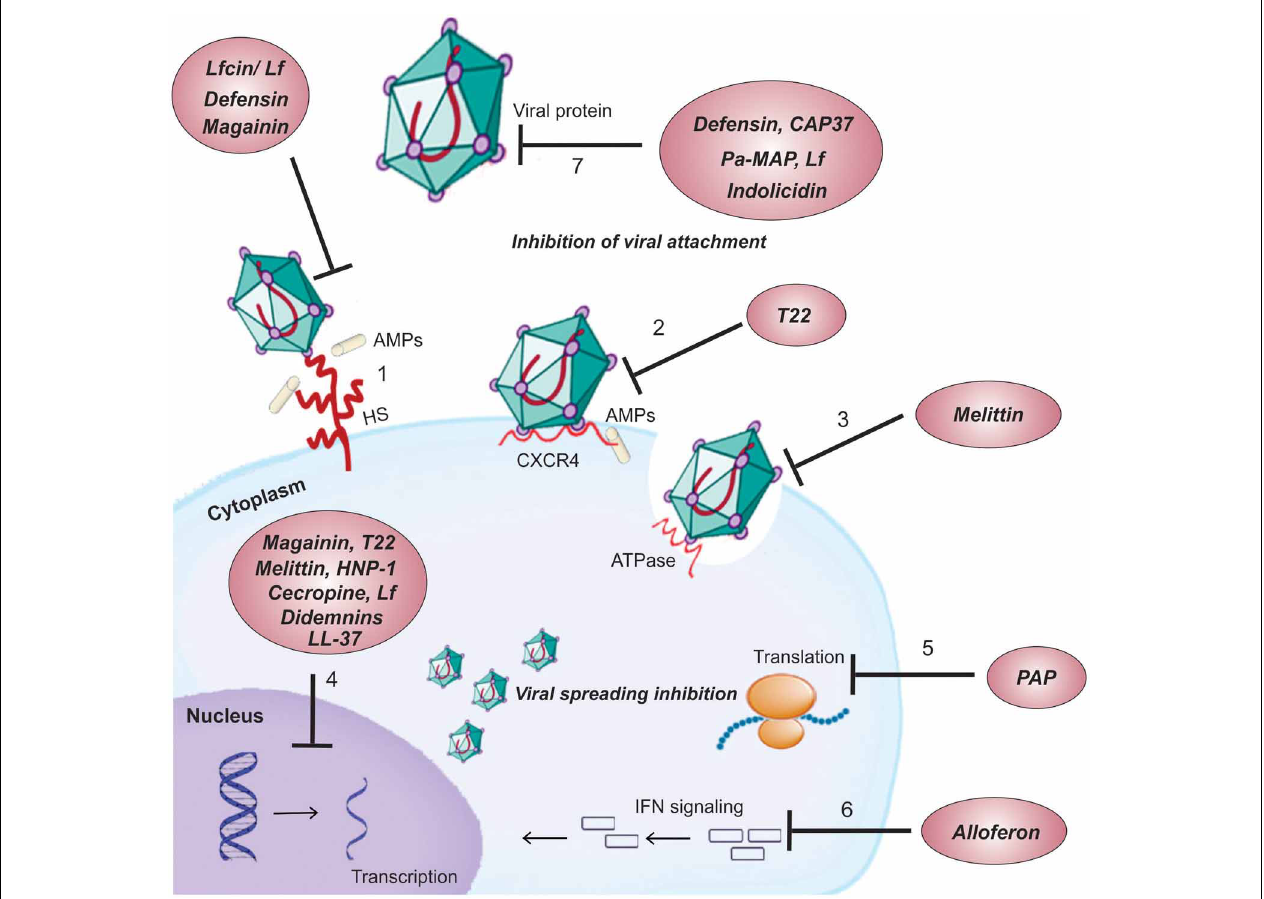
FIGURE 3 | Mechanisms of action of cationic antiviral peptides. Cell surface targets : (1) Interaction of peptides with different glycosaminoglycan (e.g., HS) present on the cell surface competing with the virus for cellular binding sites. (2) Blocking of viral entry into the cell by binding the peptide to viral CXCR4co-receptor required for its entry. (3) Suppression of cell fusion by